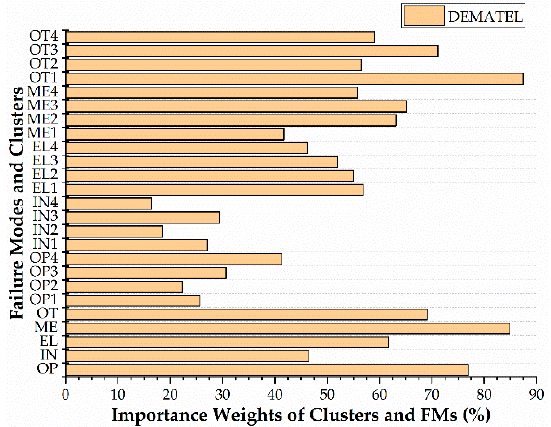
Figure 8. DEMATEL weights for clusters and FMs.